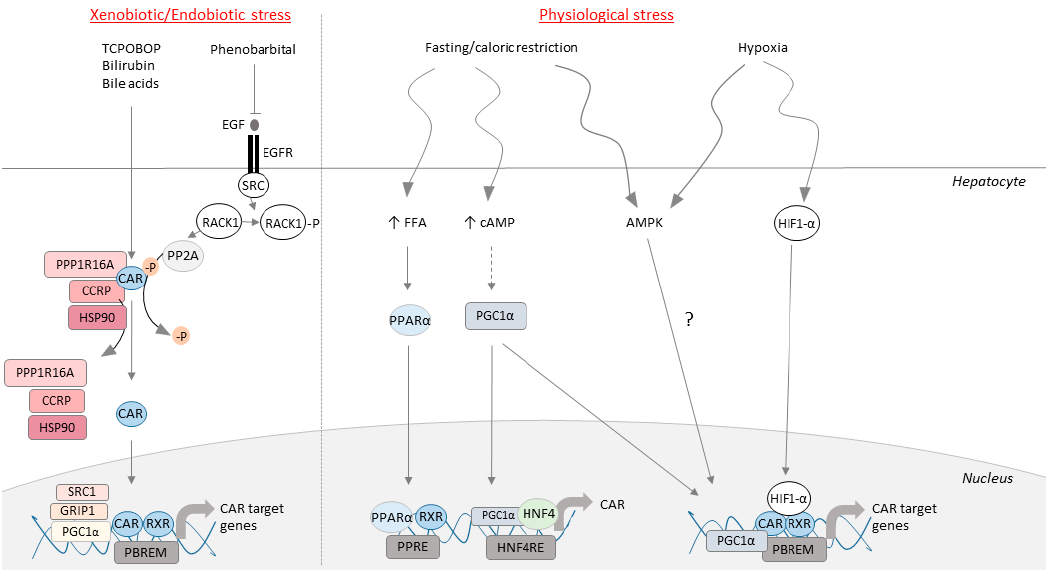
Figure 1. CAR is a sensor for xenobiotic/endobiotic and physiological stress. CAR is maintained in the cytoplasm by a complex of chaperone proteins (PP1R16A, CCRP, HSP90) and can be activated through direct or indirect processes by a xenobiotic or endogenous molecule. Dephosphorylation of CAR allows it to be free from its chaperone complex, to migrate to the nucleus, heterodimerize with RXR, recruit co-activator factors and allow transcription of its target genes. Gene expression of CAR is induced in response to fasting and caloric restriction through nuclear receptors PPARa and HNF4. Hypoxia induces nuclear translocation of CAR and expression of its target genes through HIF1. CAR can be activated by endogenous and exogenous molecules without direct binding.